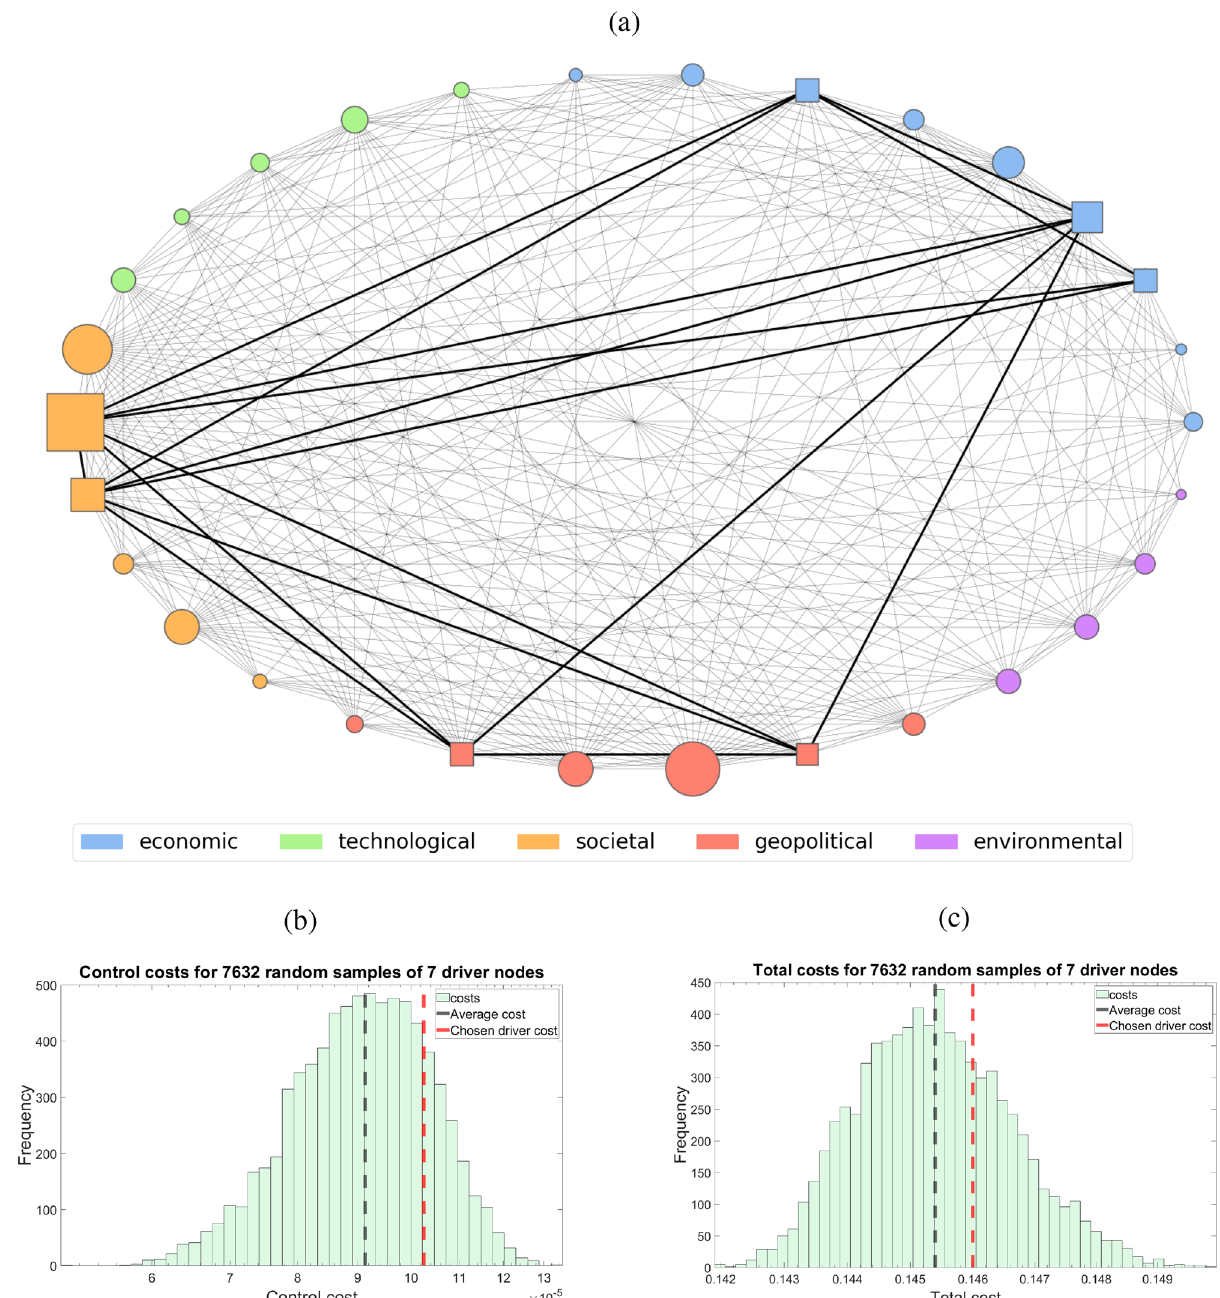
Figure 2. The cost of controlling infectious disease within the 2020 GER network. Incurred cost from LQR control for random samples of 7 driver nodes on the 2020 GER network with the “rapid and massive spread of infectious diseases” risk held constant at one. The network itself is dense and near regular with mean vertex degree of 18.27 and standard deviation of 4.60. We compare the 7 node costs with that of the nodal set consisting of deflation, failure of major financial institutions, unemployment, failure of national governance, failure of global governance, failure of urban planning, and profound social instability. In the above network we have highlighted the nodes within the 2020 GER network these drivers consist of by making them square. We can see that this driver set performs worse than an average randomly chosen driver set in both total cost and control